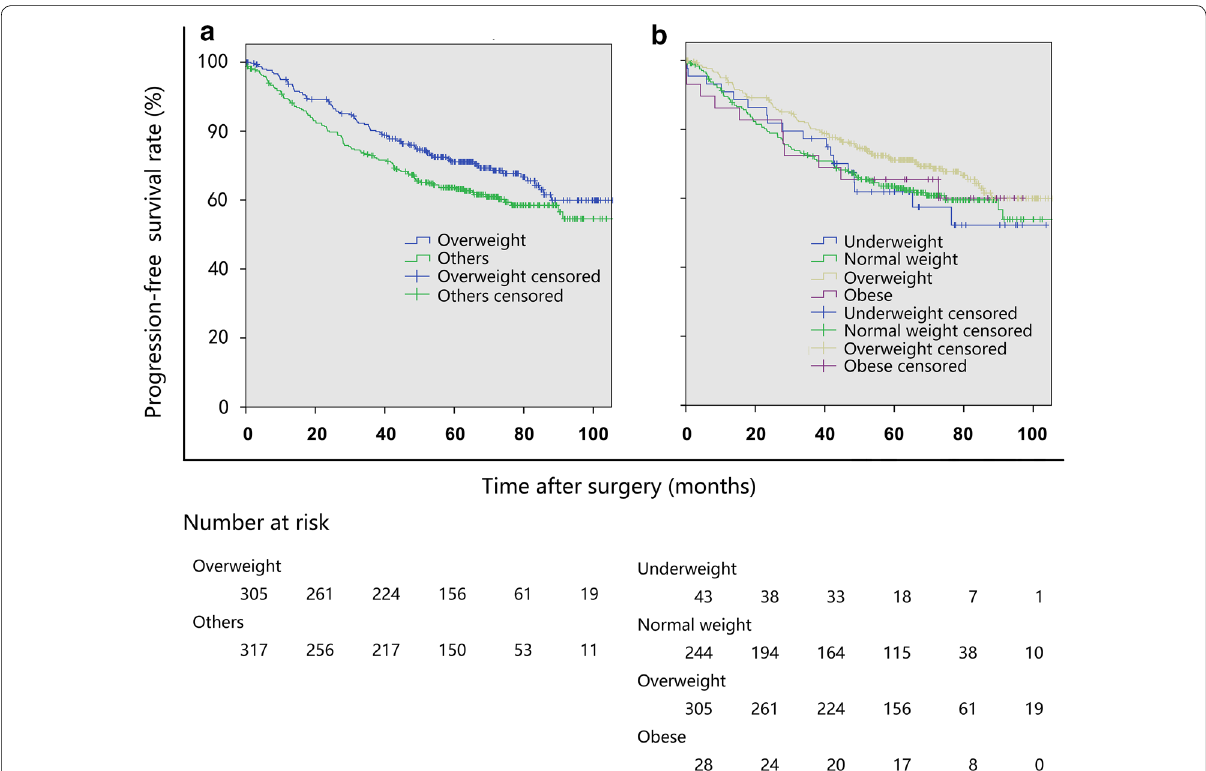
Fig. 2 Kaplan–Meier progression‑free survival (PFS) curves of patients with stage I NSCLC stratified by BMI. a The PFS was longer in the overweight group than in other groups in combination ( P but differences were not significant between the overweight group and the underweight group ( P